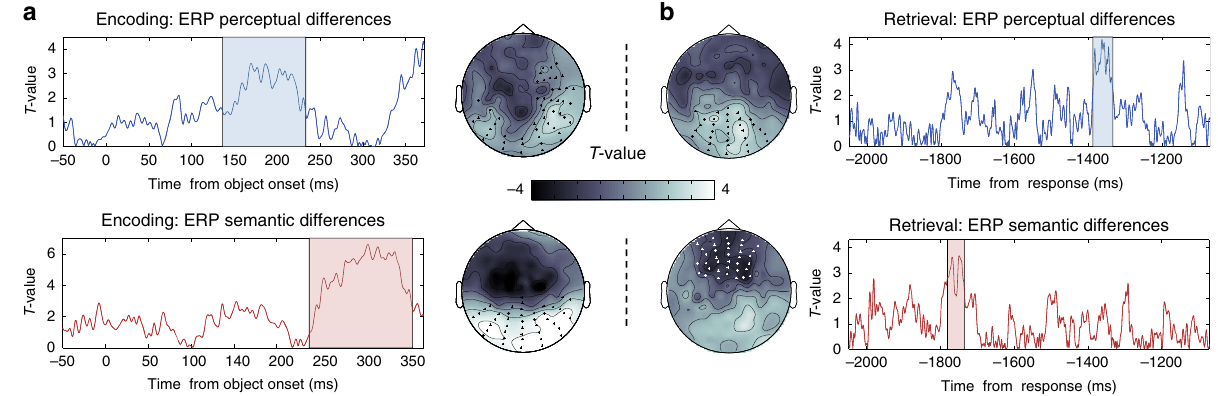
Fig. 5 Univariate analysis results. a Left panels represent ERP group differences ( T values) across time in those electrodes that formed a signi fi cant cluster during object presentation, locked to the onset of the stimulus. Top left panel shows the contrast of photographs vs. line drawings, and the bottom left panel differences between animate vs. inanimate objects. Scalp fi gures next to each contrast illustrate the maximum cluster ’ s topography, averaged across the signi fi cant time-window, with all signi fi cant electrodes in a cluster being marked with an asterisk. b Right panels show ERP group differences ( T values) over time in those electrodes that are contained in the maximum signi fi cant clusters during memory retrieval, time locked to participants ’ responses. The top right panel shows the perceptual contrast, and the bottom right panel the semantic contrast. Cluster topographies for each comparison are located next to each panel, and the temporal extent of signi fi cant clusters is shaded in